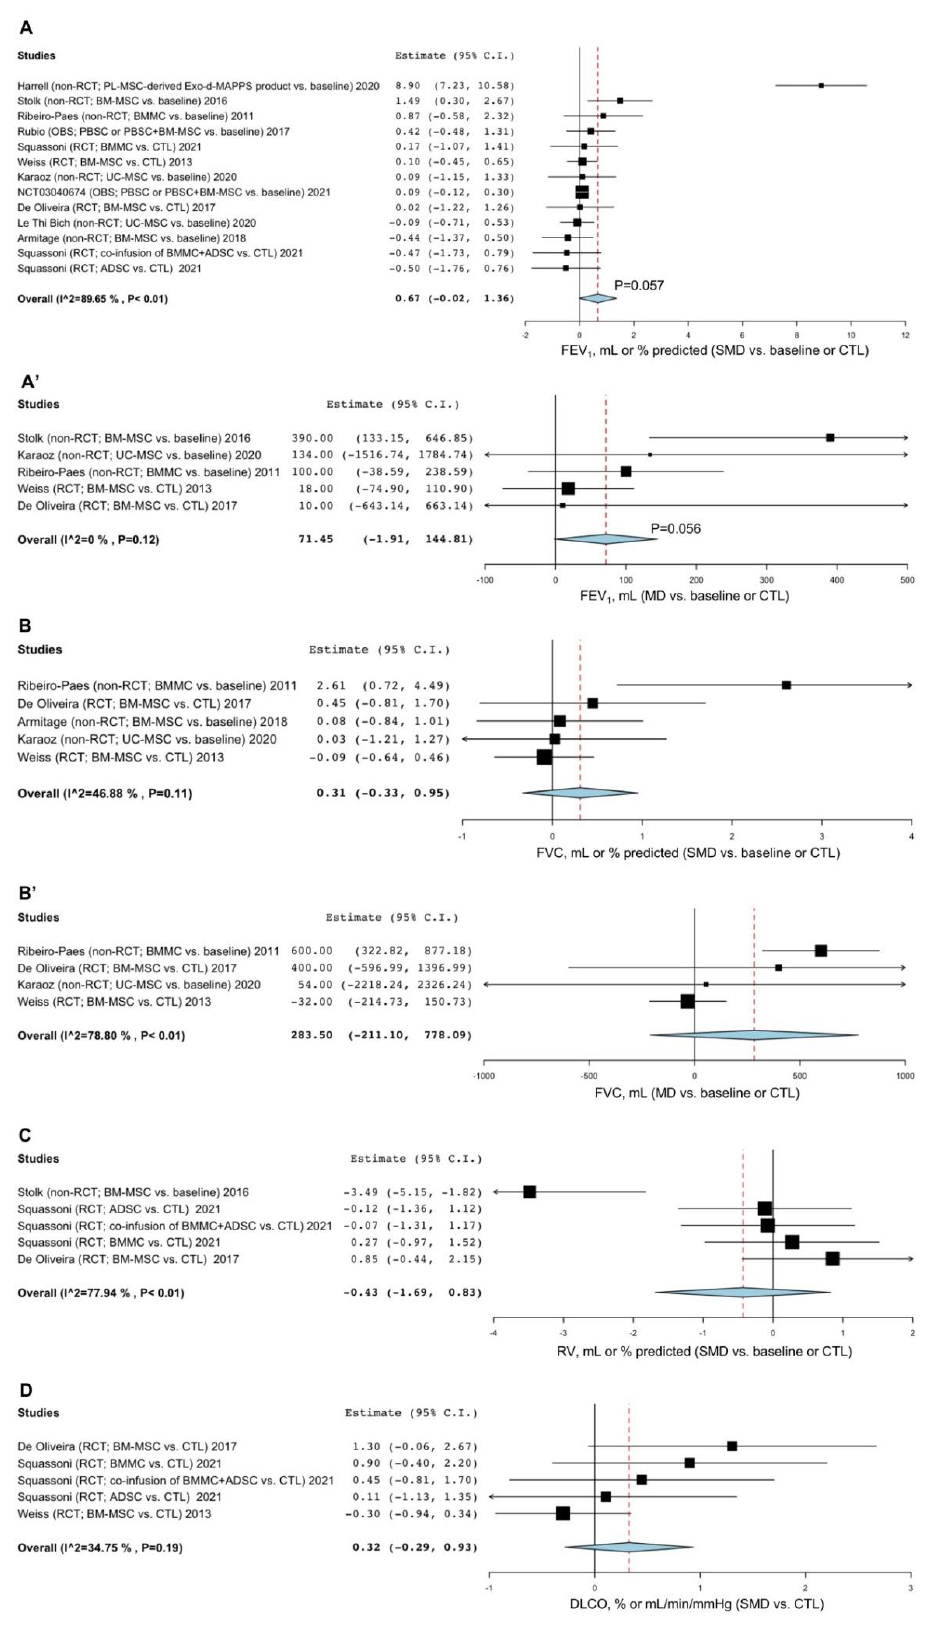
Figure 2. Forest plots of the impact of stem cell-based regenerative therapies vs. baseline or CTL on FEV 1 ( A ), FVC ( B ), RV ( C ), and DLCO ( D ) and subgroup analysis on the MD in FEV 1 ( A ’) and FVC ( B